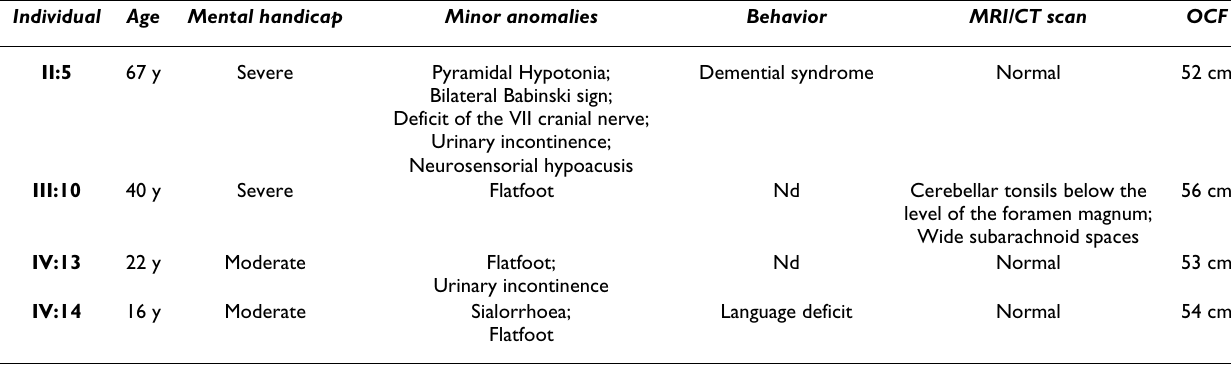
Table 1: Synopsis of MRX87 male patients